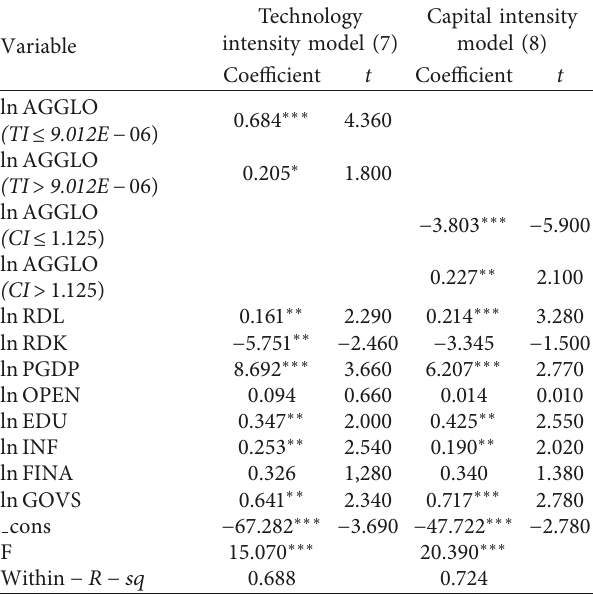
Table 7: Threshold model estimate